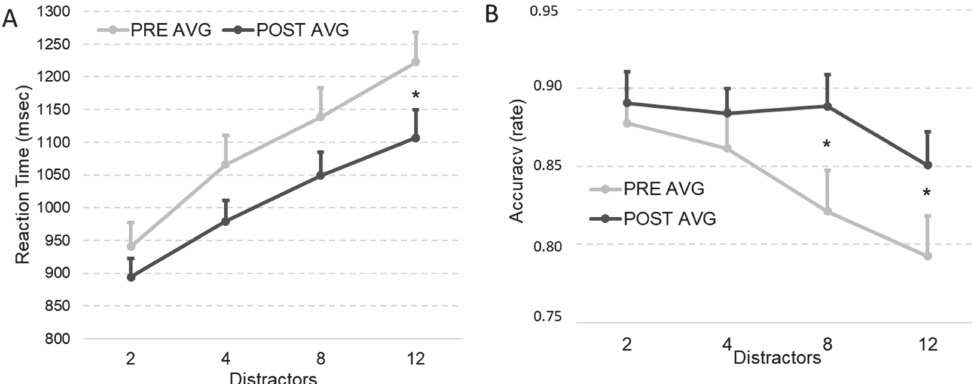
Figure 3. Panel ( A ): reaction times (in msec) in visual search before (PRE AVG) and after (POST AVG) action video game training. Panel ( B ): accuracy (in rate) in visual search before (PRE AVG) and after (POST AVG) action video game training. Error bars report the mean standard error. The asterisks indicate the significant